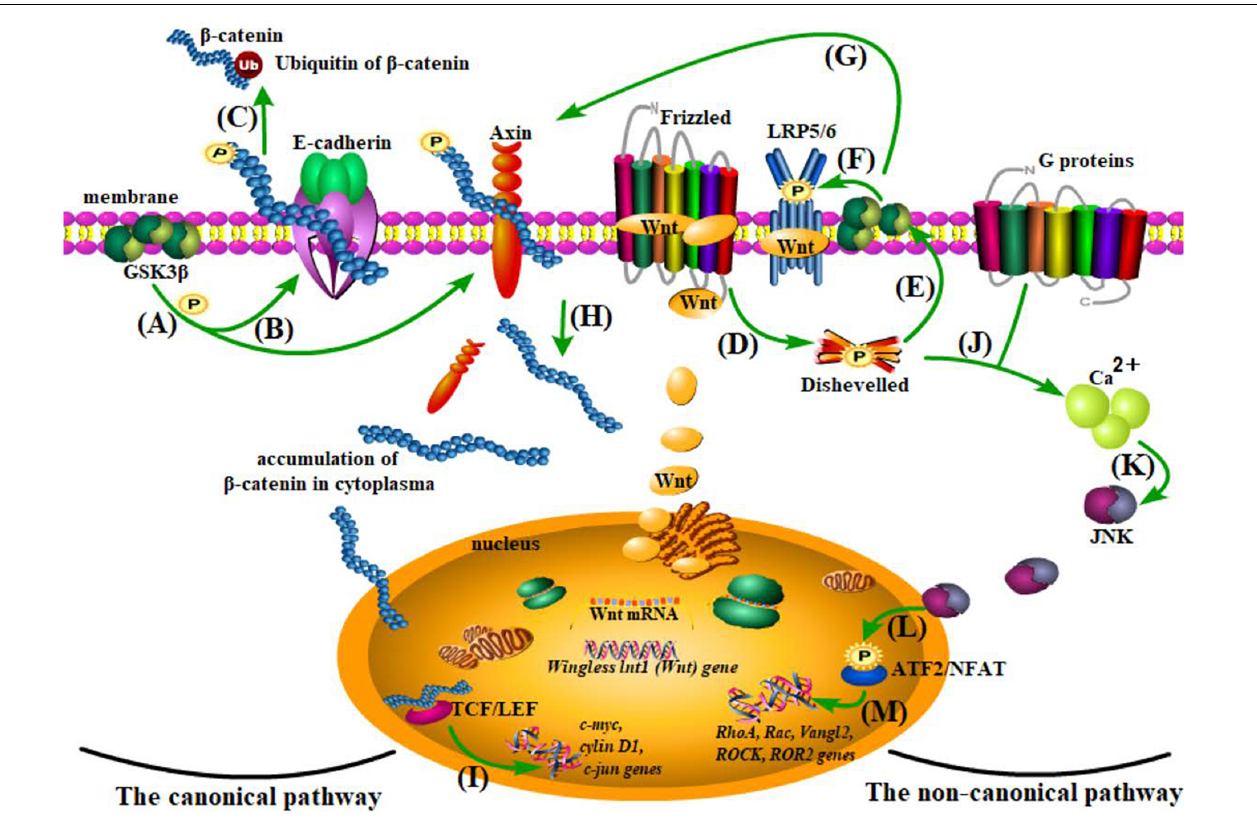
FIGURE 2 | The Wnt pathways. (A–C) β -catenin degradation: under normal conditions, β -catenin is anchored to the cell membrane with E-cadherin and Axin and goes to ubiquitination after being phosphorylated by glycogen synthase kinase 3 (Gsk3 β ). (D–I) The canonical pathway: when Wnt combines with the cysteine-rich region of its receptor protein, Frizzled (FZD), and the coreceptor-low density lipoprotein receptor-related protein 5/6 (LRP5/6) acts on the Disheveled (Dvl) protein and inhibits Gsk3 β , thus separating β -catenin from Axin, the accumulated β -catenin from plasma to nucleus is capable of enhancing the activity of TCF/LEF (a transcriptional factor) and therefore influencing gene transcription of c-myc , cylin D1 , c-jun , etc. (J–M) The non-canonical pathway: the activation of the Wnt/planar cell polarity (PCP) and the Wnt/Ca 2 + pathways, although independent of β -catenin, share the initial process (Wnt combines with receptors and activates Dvl) with the canonical pathway. With the assistance of G proteins, Ca 2 + is recruited in the plasma to cause cascade reactions and finally affect transcription of Rac , RhoA , Vangl2 , ROCK , and ROR2